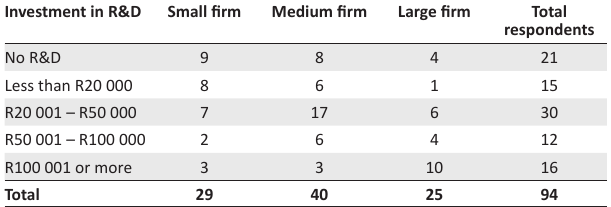
TABLE 2: Chi-square test for association between external input and size of